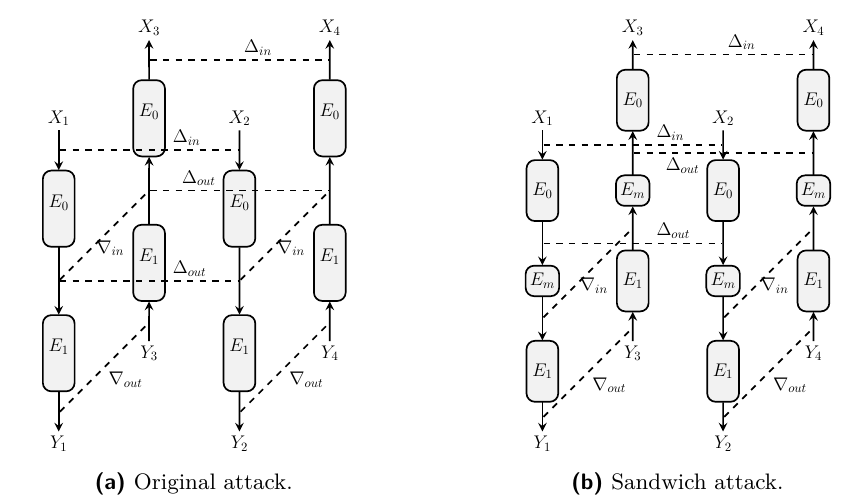
Figure 1: Diagrams of boomerang